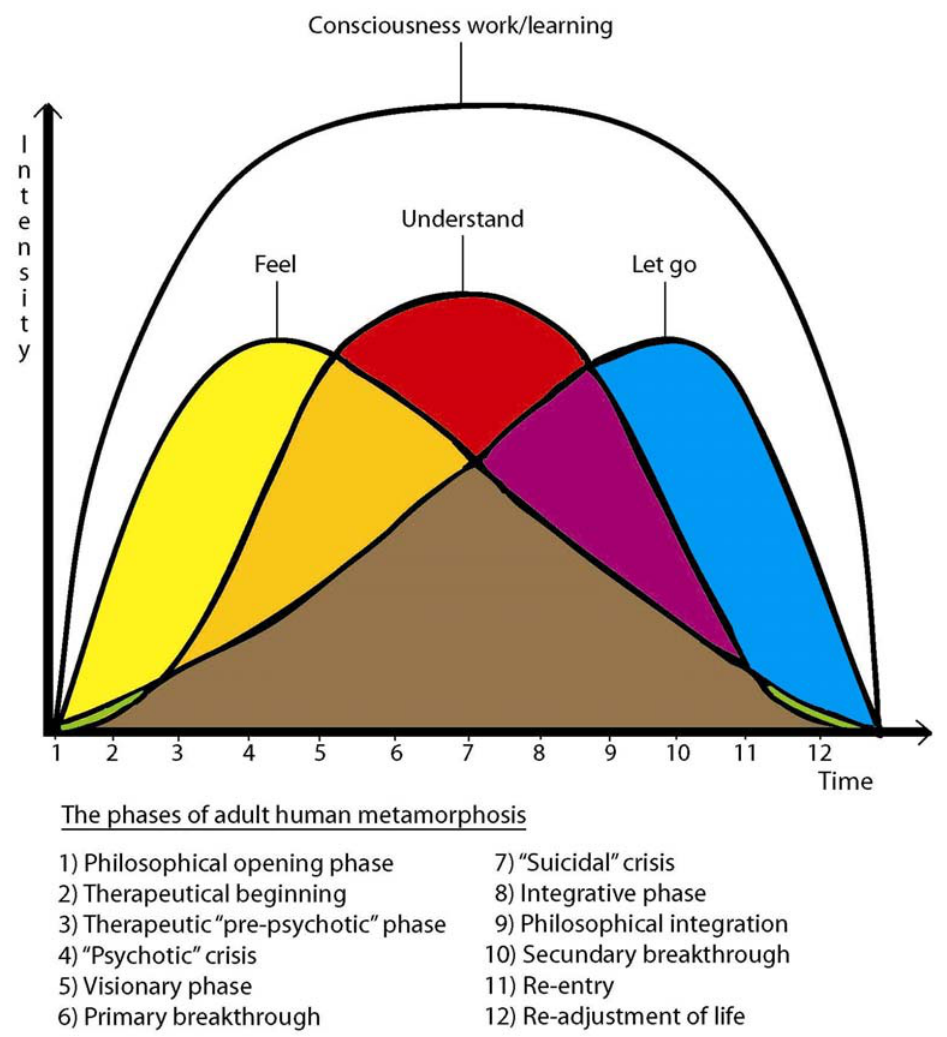
FIGURE 1. The process of holistic healing seen as three phases of feeling (yellow), understanding (red), and letting go (blue) of negative beliefs, attitudes, and decisions. As an end result, the process was improving the patient’s philosophy of life and thus allowed the patient to rebalance existence and to assume responsibility for life. During the process, the patient’s will re-established quality of life, health, and existential coherence, along with the ability to love, understand, and enjoy the whole spectrum of feelings and emotions, including sexuality. Many patients in intensive therapy experience the healing as a series of phenomena or breakthroughs and existential crises with characteristic content. The most intense crises are metaphorically called the “psychotic”, the “visionary”, and the “suicidal” crises. They include feelings of going insane, not knowing the world or oneself, and wanting to die. Knowing what is coming next in the course of therapy is of great help to the patient, making it much easier to confront and integrate the often extremely intense, painful emotions and states of being, arising from integrating the early childhood traumas. The 12 steps (see figure) are some possible steps in the process of healing and human transformation; understood though an ancient and powerful metaphor as the steps of “human